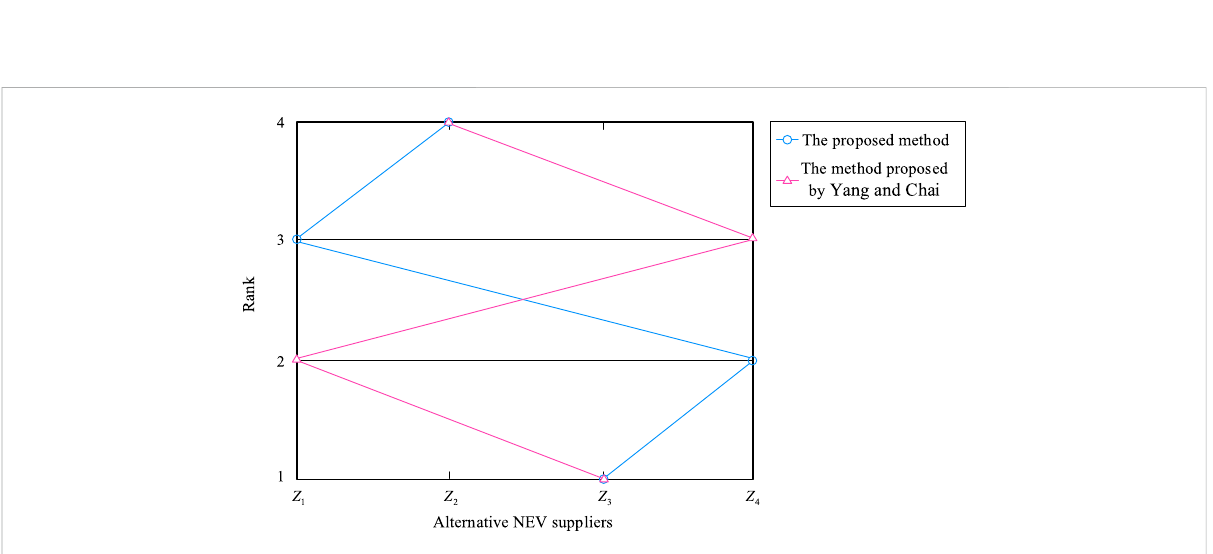
FIGURE 13 Screenshot of retrieval results.